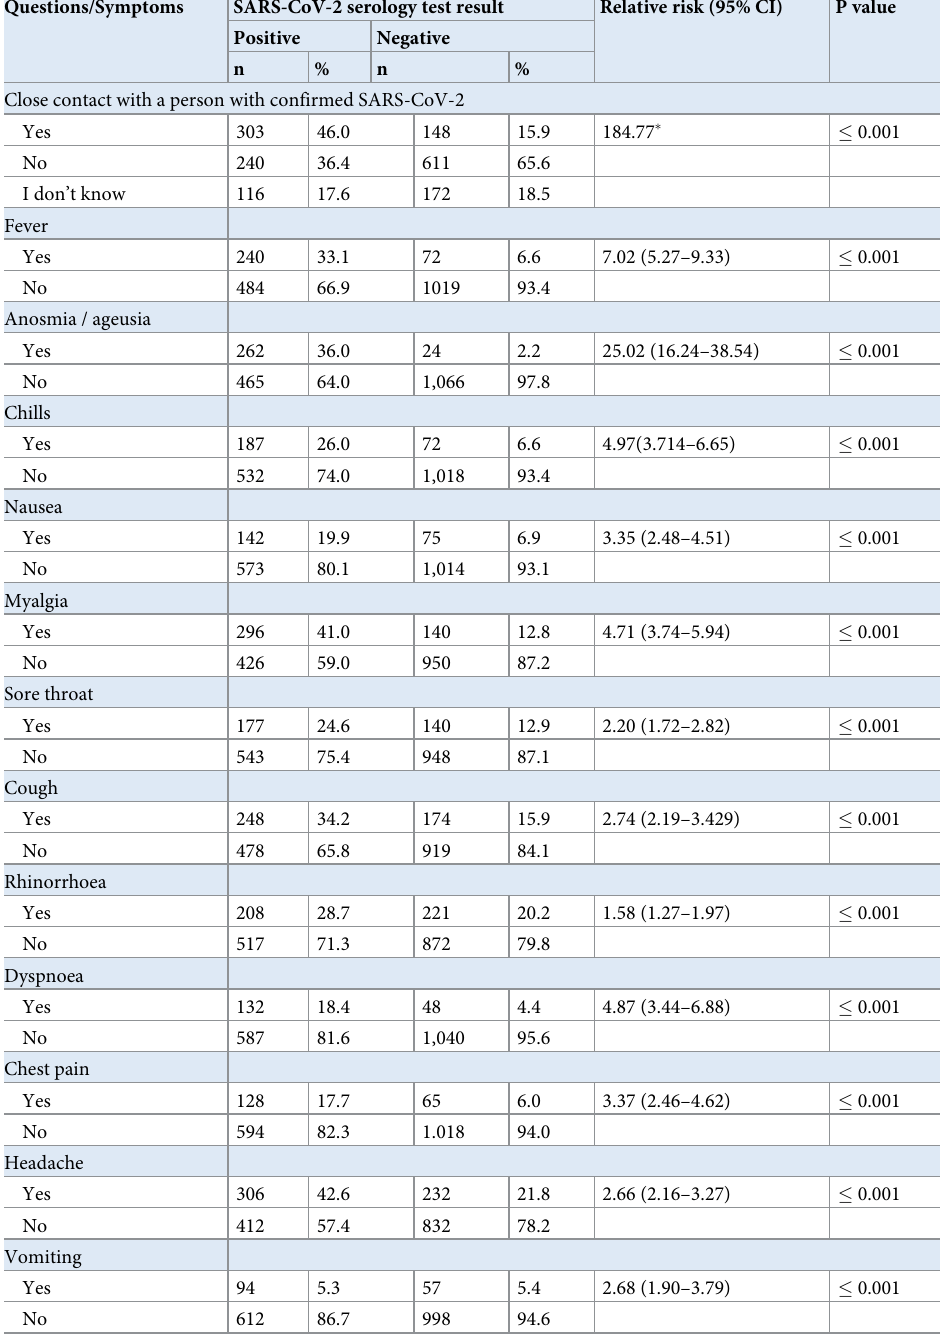
Table 2. Symptoms and signs of COVID-19 in relation to SARS-CoV-2 seropositivity. Questions/Symptoms SARS-CoV-2 serology test